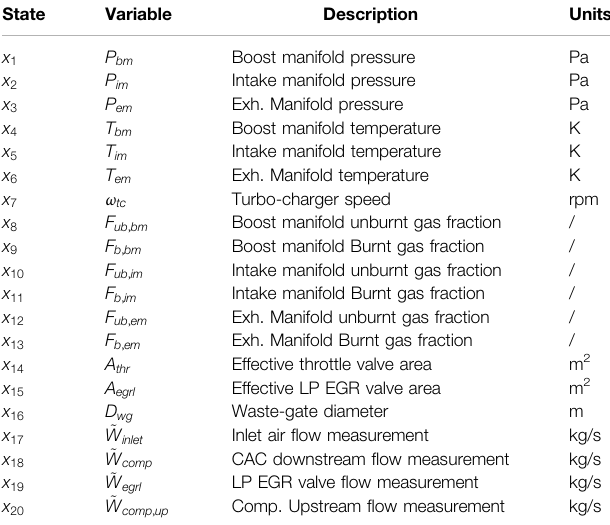
TABLE 2 | State variables for the engine model.